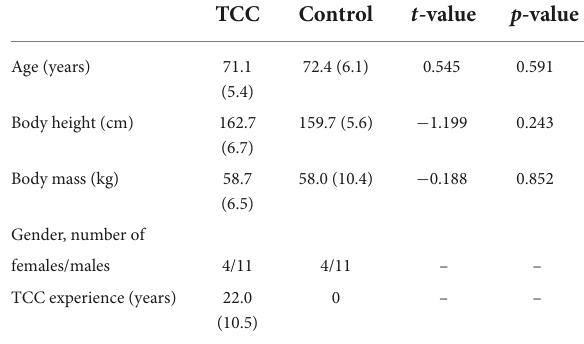
TABLE 1 Means (standard deviations) of the demographic characteristic for the TCC ( n = 15) and Control ( n = 15) groups. P -values and t -values for between-group comparisons using independent t -tests are also